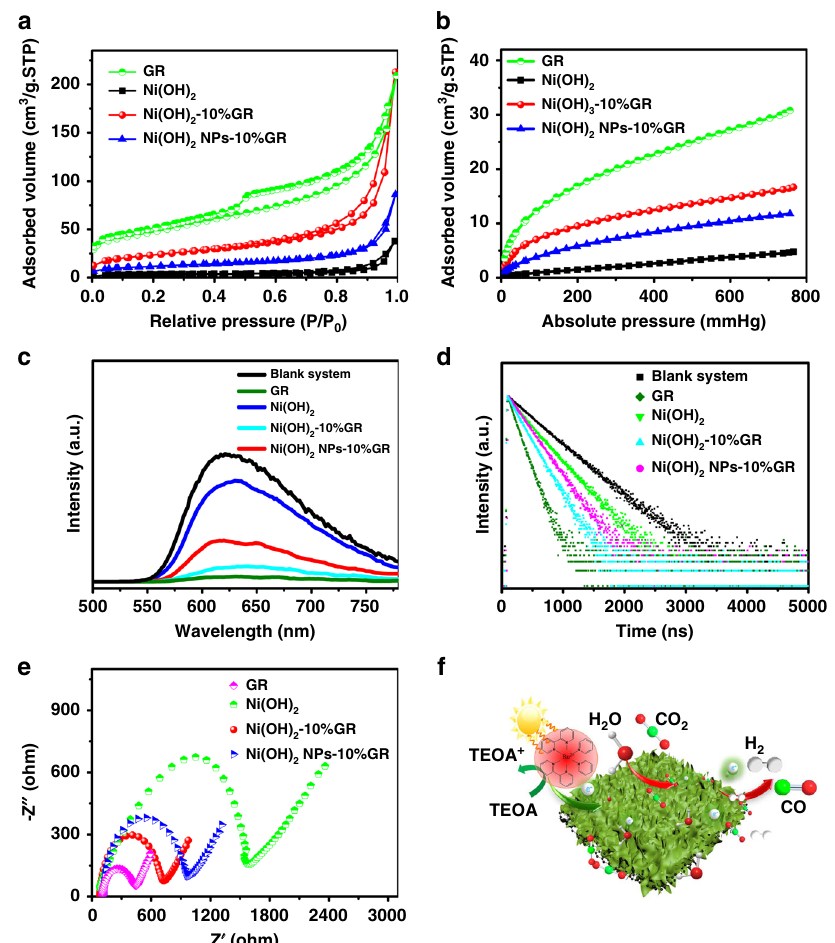
Fig. 4 CO 2 adsorption and photoelectrical properties of various photocatalysts. a N 2 adsorption-desorption isotherms and b CO 2 adsorption isotherms of GR, Ni(OH) 2 , Ni(OH) 2 NPs-10%GR and Ni(OH) 2 -10%GR. c Steady-state PL spectra and d time-resolved PL spectra decay of the photocatalytic CO 2 reduction systems with cocatalysts of GR, Ni(OH) 2 , Ni(OH) 2 NPs-10%GR, Ni(OH) 2 -10%GR and without cocatalysts. e EIS Nyquist plots of GR, Ni(OH) 2 , Ni (OH) 2 NPs-10%GR, and Ni(OH) 2 -10%GR. f Proposed photocatalytic mechanism of Ni(OH) 2 -10%GR with Ru photosensitizer for visible-light-driven photocatalytic CO 2 reduction